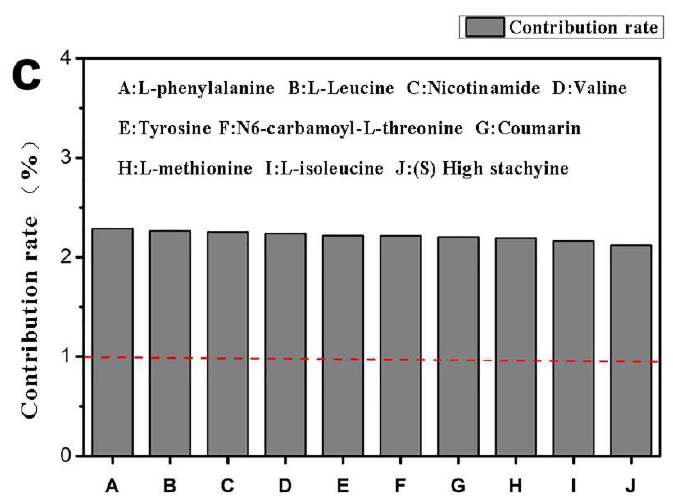
Figure 6. Scree plot of L-02 cell metabolites (( A ): Interpretable variance for each principal component; ( B ): Metabolites in Principal Component 1; ( C ): Metabolites in Principal Component 2).